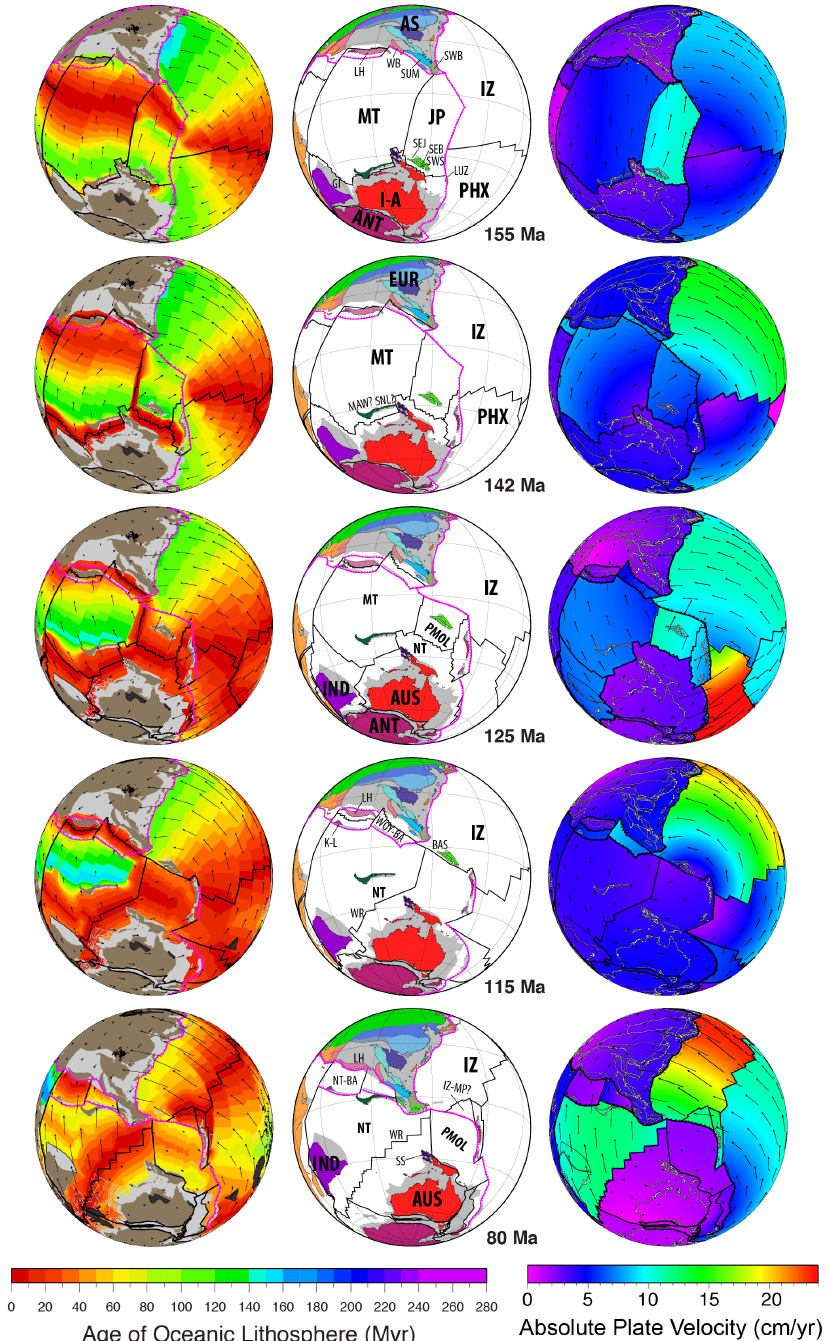
Fig. 12b. Plate reconstructions with colored blocks (middle), seafloor ages (left) and plate velocities (right). Northern Gondwana experiences a rifting event in the latest Jurassic ( ∼ 155Ma), and we implement the detachment of Argoland continental fragments, easternmost Borneo, East Java, Mangkalihat and West Sulawesi at this time. The embryonic portionsofthePhilippineArcarelikelyrelatedtotheeasternmostportionofTethyanseafloorspreadingwithsupra-subductionaffinitiesoflatestJurassic–EarlyCretaceousvolcanics. The intra-oceanic subduction system in the central Neo-Tethys (K-L, NT-BA), accommodating India–Eurasia convergence, also becomes established in the Early Cretaceous. Gondwana-derived continental fragments begin to collide with the intra-oceanic subduction system in the mid-Cretaceous, and suture to Sundaland by ∼ 80Ma and to West Burma/Sumatra by ∼ 70Ma. A pre-existing transform on the eastern margin of the Philippine Sea plate converts to a west-dipping subduction zone consuming Pacific crust by ∼ 55Ma. Continued convergence of Indo-Australia with Eurasia results in the contact of the Sula Spur with the Java–Sunda trench by ∼ 25Ma. The Sepik composite terrane docks to New Guinea by 27Ma, followed by accretion of the Prince Alexander–Finisterre–Torricelli arc from 6Ma. Subduction zones–magenta teethed lines, transforms/MORs–black lines, continental extent–grey, large igneous provinces (LIPs)–dark grey. AS–Asian Plate, EUR–Eurasian Plate, MT–Meso-Tethys, NT–Neo-Tethys, JP–Junction Plate, PMOL– proto-Molucca Plate, IZ–Izanagi Plate, PHX–Phoenix Plate, I-A–Indo-Australian Plate, ANT–Antarctic Plate, AUS–Australian Plate, IND–Indian Plate, GI–Greater India, LH–Lhasa, WB–West Burma, SUM–Sumatra, SWB–southwest Borneo, SEJ–southeast Java, SEB–southeast Borneo, SWS–southwest Sulawesi, LUZ–Luzon, N-S/PSP– northern/southern Philippine Sea plate, SS–Sula Spur, WR–Wharton Ridge, NT-BA–Neo-Tethyan back arc, K-L–Kohistan–Ladakh, WOY-BA–Woyla back arc, BAS–Barito Sea, MAW–Mawgyi microcontinent, CAP–Capricorn Plate, SNL–Sikuleh, Natal, Lolotoi and Bengkulu microcontinents, IZ-MP?–Izanagi microplate?, CP–Caroline Plate, SOL–Solomon Sea plate. Digital animations are included in the Supplement (orthographic projection with center co-ordinate 15 ◦ S, 110 ◦ E). www.solid-earth.net/5/227/2014/ Solid Earth, 5, 227–273,